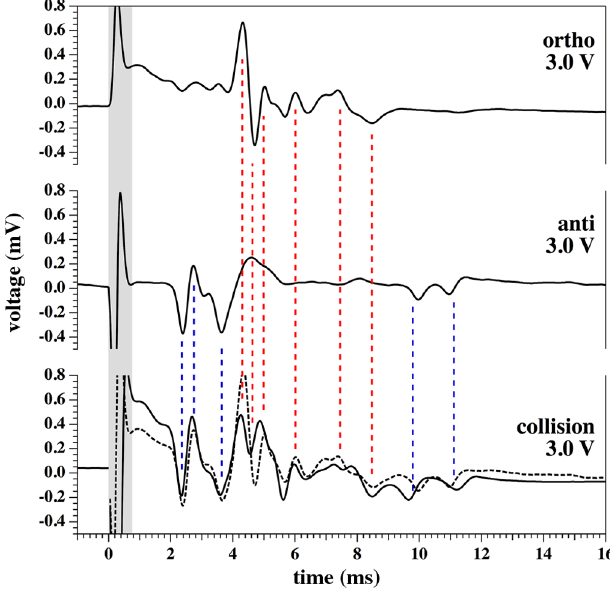
FIG. 9. Left: Action potentials after stimulation in the ortho- dromic direction show the successive generation of action potentials in the giant axons when increasing the stimulation voltage. Right: The collision experiment in the abdominal part of the ventral cord of a lobster at a stimulation voltage of 2 V. Top: Stimulation in the orthodromic direction only. Center: Stimula- tion in the antidromic direction only. Bottom: Collision experi- ment (solid line) compared with the sum of the top (orthodromic) and the center (antidromic) traces (dashed line). The two traces are virtually superimposable. (center). Figure 9 (bottom right) shows the collision